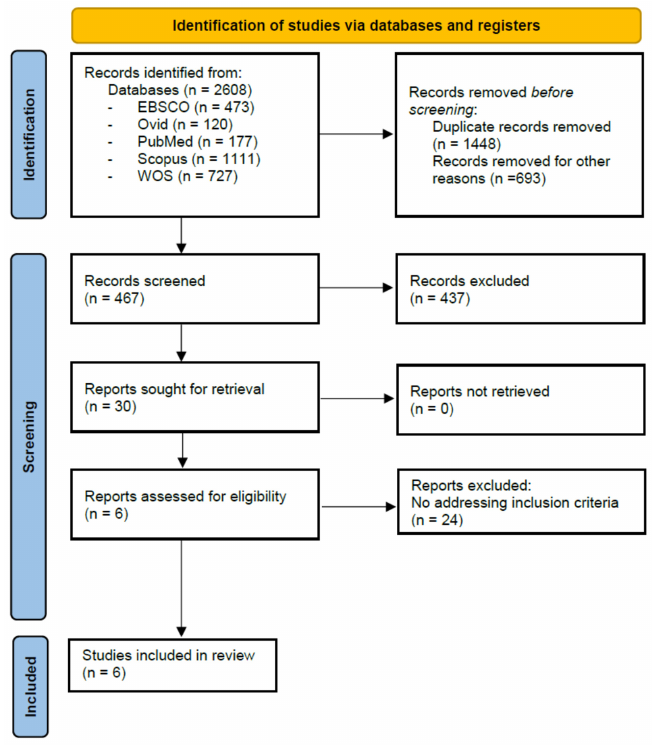
Figure 1. Systematic review of the literature